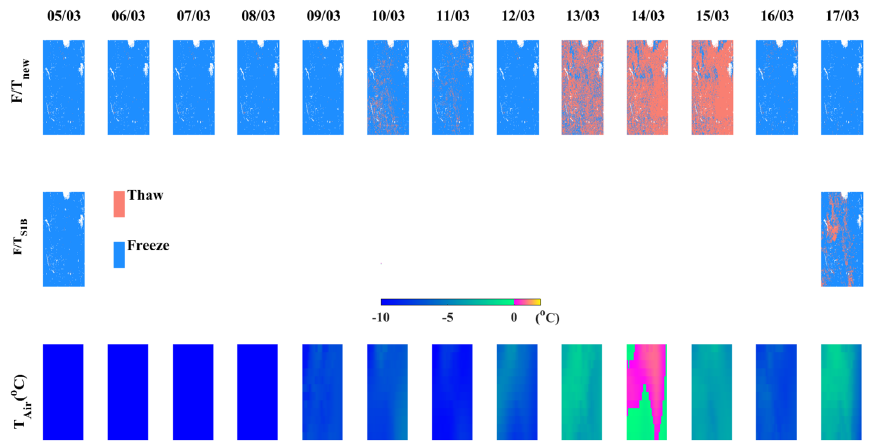
Figure 15. Same as Figure 13 but over the RISMA area from 5 March 2019 to 17 March 2019.